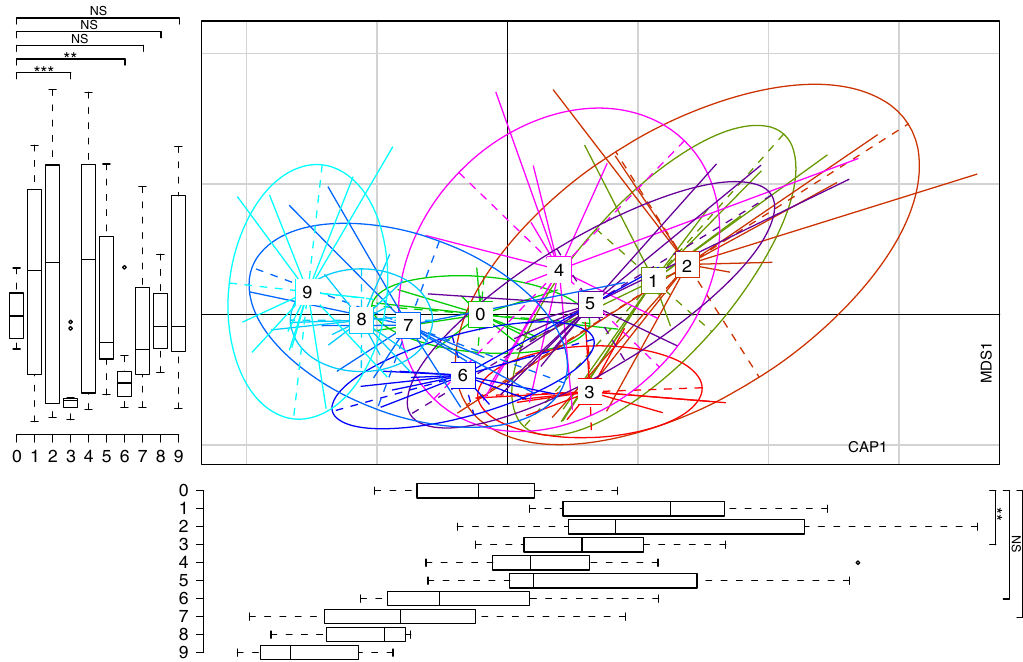
Fig. 5 Predicting students ’ gut microbiotas in the next 3 months using a dynamic Bayesian network model. DbRDA of the Bray – Curtis PCoA of the unweighted UniFrac distances between the gut microbiota in samples at the seven time points tested and three predicted future time points. Display is based on sample scores on the primary constrained axis (CAP1, 2.2% variance explained) and primary multidimensional scaling (MDS1, 20% variance explained). Lines connect samples taken at the same time point, and colored circles indicate the samples near the center of gravity for each time point. Below and left boxplots show the sample scores in CAP1 and MDS1 (boxes show medians/quartiles; error bars extend to the most extreme values